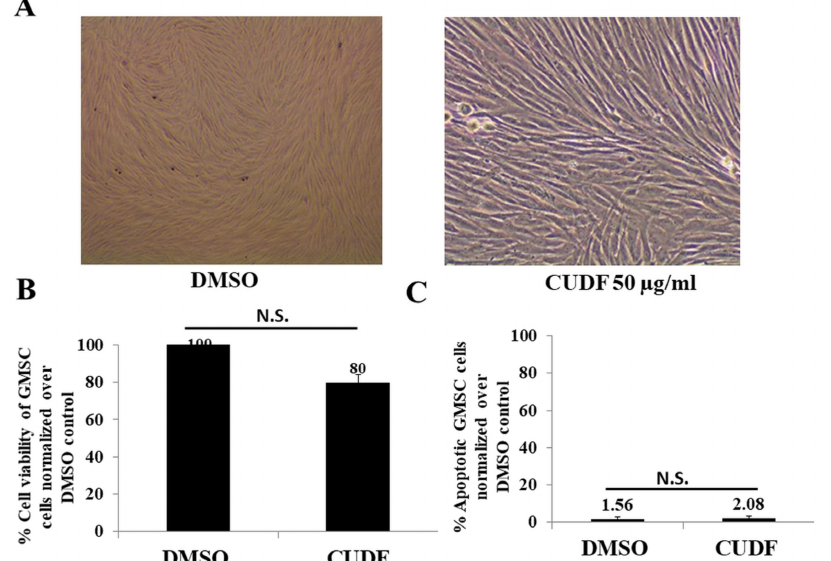
Figure 5. Effects of CUDF upon GMSCs in terms of cell viability and apoptotic cell death. ( A ) GMSCs were treated with DMSO and CUDF (50 µ g/mL) for 72 hr. Photomicrographs were captured at 100 × magnification at the end of incubation for 72 h. ( B ) GMSCs were treated with DMSO and CUDF (50 µ g/mL) for 72 h. The percentage of cell viability was estimated by a trypan blue due exclusion assay. ( C ) GMSCs were treated with DMSO and CUDF (50 µ g/mL) for 72 h. At the end of incubation, GMSCs were stained with PI and annexin V, and stained cells were measured by a flow cytometer. The percentage of apoptotic MCF-7 cells was estimated by counting the percentage of PI- and annexin-V stained MCF-7 cells. Data are represented as mean ± SD. Each experiment was conducted independently three times. The bar graph without an asterisk denotes no significant difference compared to the DMSO